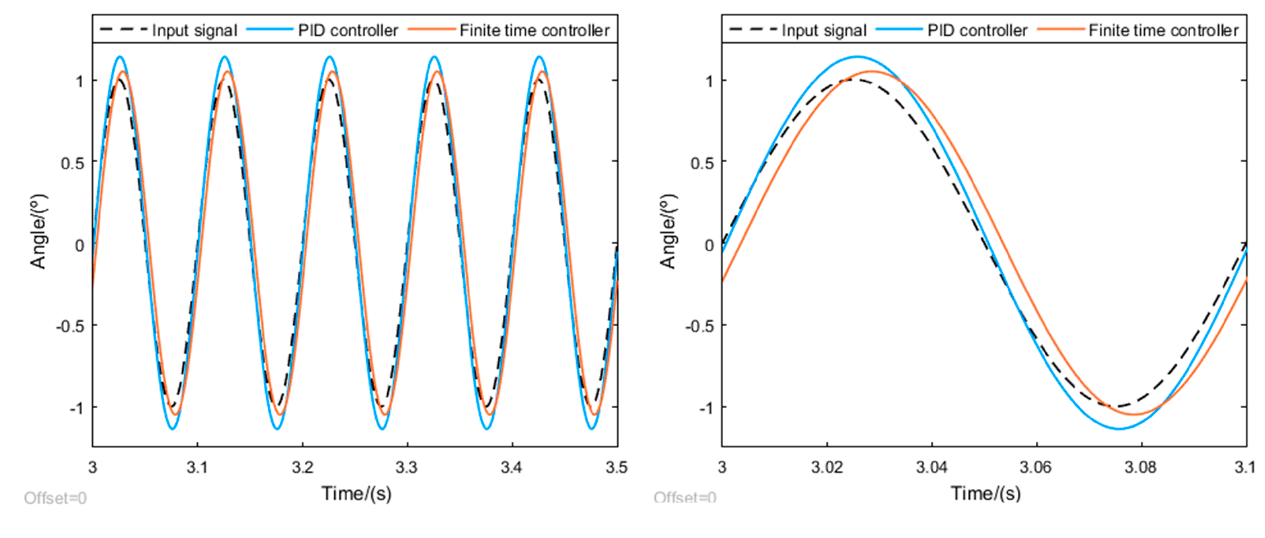
Figure 8. Finite-time composite control response curve of the motor system with 9 Hz and 1 ◦ sinusoidal signal.